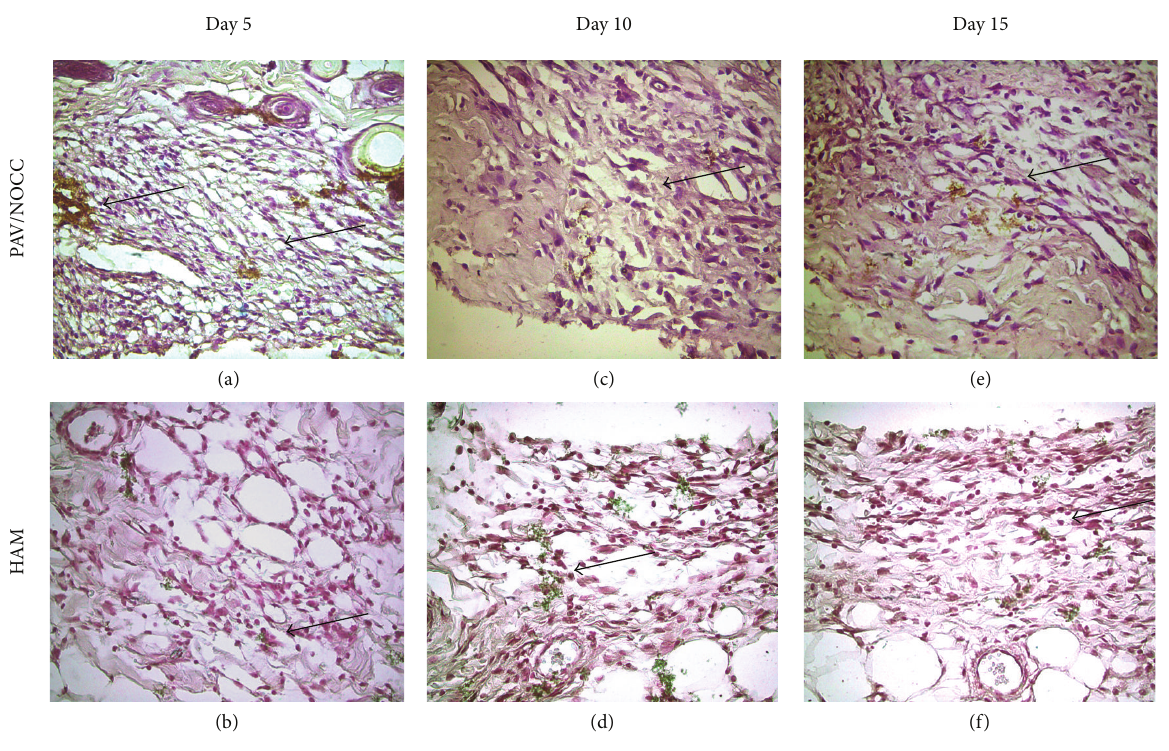
Figure 3: Immunohistology staining for CD 68 of the PVA hydrogel and HAM after 5, 10, and 15 days of subcutaneous implantation, 400x. Briefly, the samples were rinsed with phosphate buffered saline (PBS) and fixed with methanol for 15 min. Then, the samples were treated with 0.03% hydrogen peroxide for 5 min and incubated with mouse anti-rabbit anti-CD 68 antibody for 30 min at 1:100 dilutions and then with peroxidase-labeled polymer conjugated to goat anti-mouse immunoglobulin for another 30 min. The expression of CD 68 has been indicated by arrow